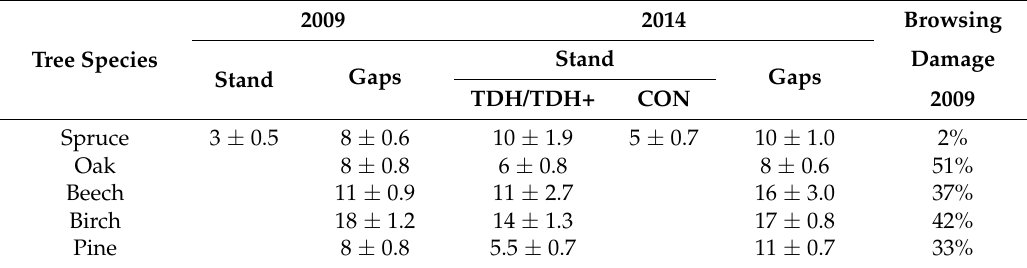
Table 5. Top shoot length with standard error (cm per year) of the tallest individual per tree species and per gap or subplot of different inventories (if available; see Table 3) and initial browsing damage of the top shoot per tree